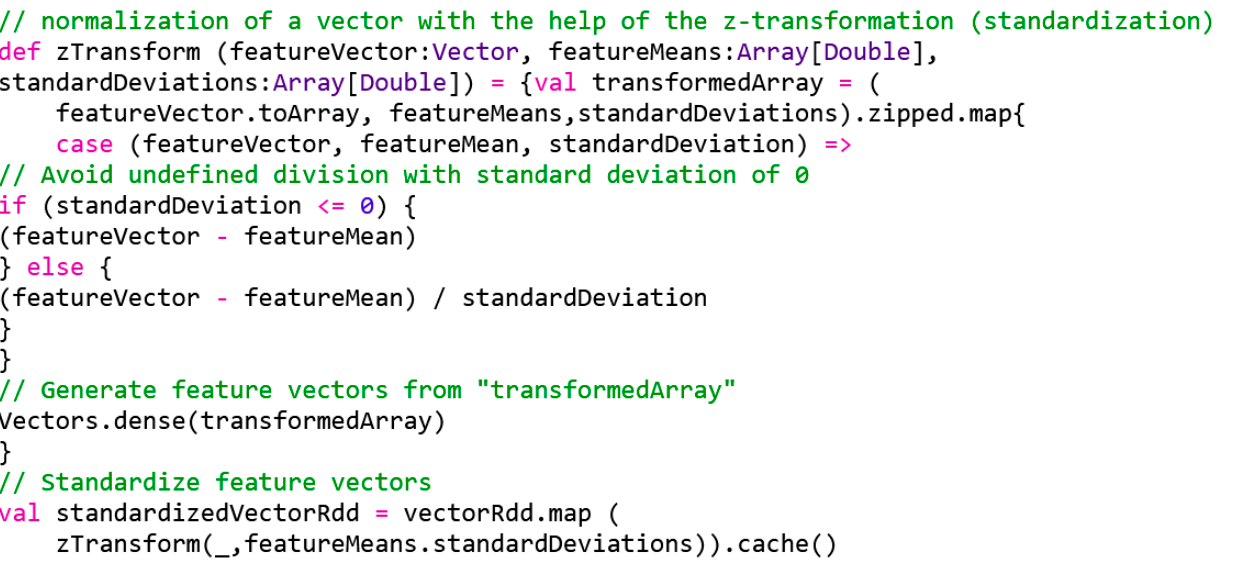
Table 4. Anomaly rates after optimizations.